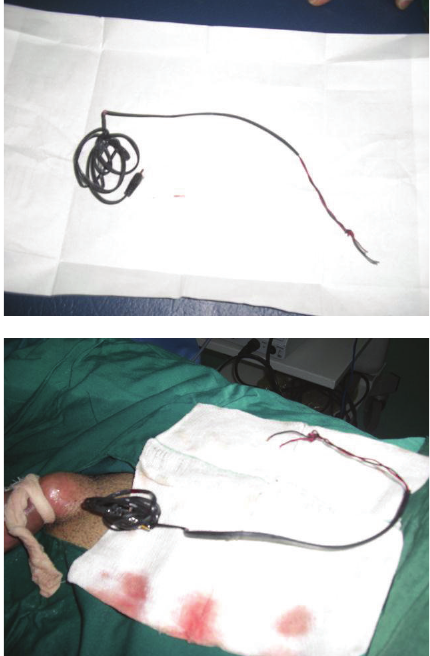
Figure 4: The removed electrical wire in its entire